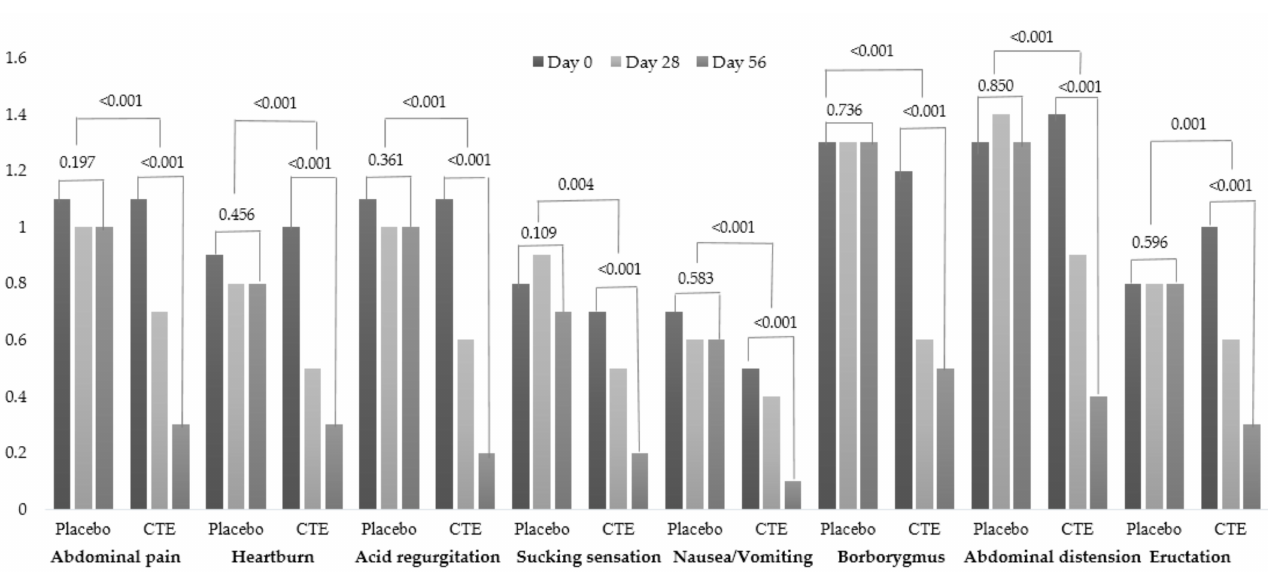
Figure 2. The changes of upper abdominal symptom scores in